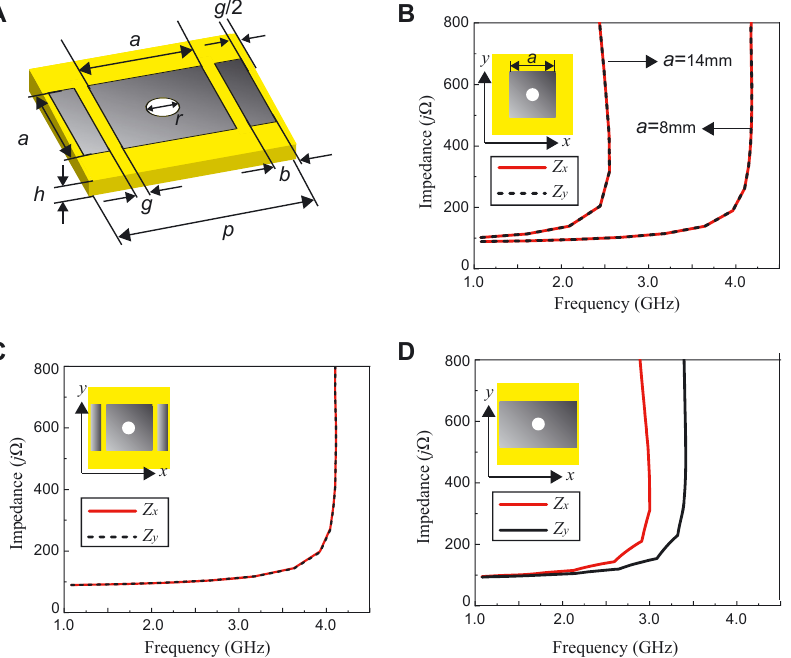
Figure 3: Details of unit cell structure and simulation results using eignemode solver. (A) Proposed unit cell structure consisting of a central square patch with a length of a connected with a via to the ground and with two rectangular side patches having a width of b placed nearby. The default dimensions are g = 1 mm, p = 15 mm, a = 8 mm, b = 2 mm, and h = 3 mm. (B)–(D) Simulation results of the unit cell structure using an eigenmode solver to extract the surface impedance. (B) is the square patch unit cell without the side patches (namely, isotropic condition). a is set not only to 8 mm but also to 14 mm. (C) is the square patch unconnected to the side rectangular patches (open-circuit, isotropic condition). (D) is the connected rectangular patch (short-circuit, anisotropic condition). The edge length of the top patch along x is a + 2 b + 2 g (i.e., 14